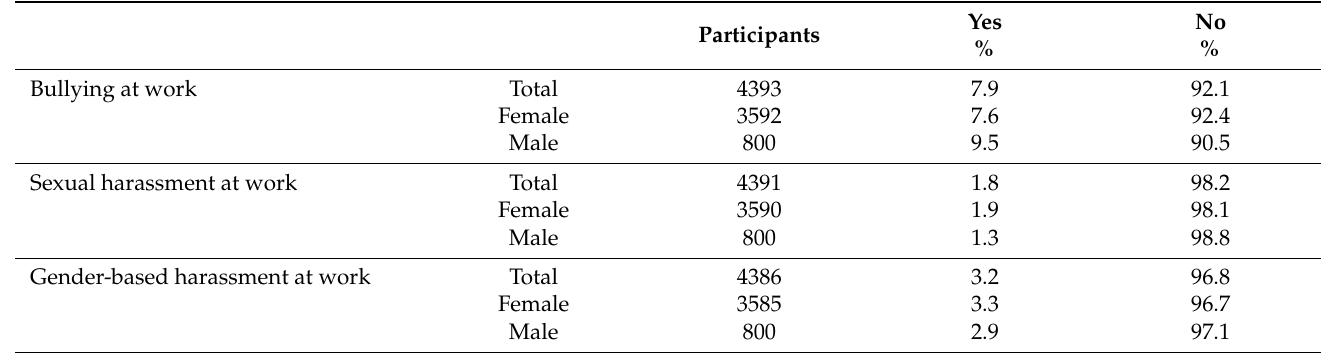
Table 3. Bullying and harassment in the current workplace past 12 months by gender.